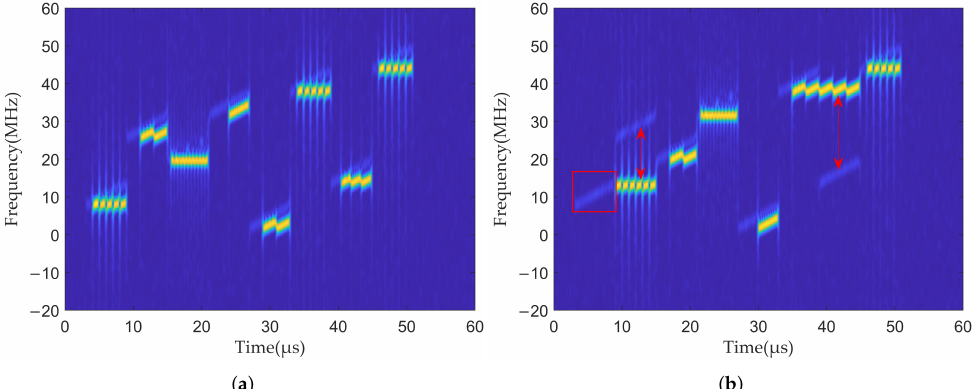
Figure 6. The time–frequency distribution of NUISRJ with and without satisfying the conditions (28): ( a ) satisfying Formula (28), ( b ) unsatisfactory Formula